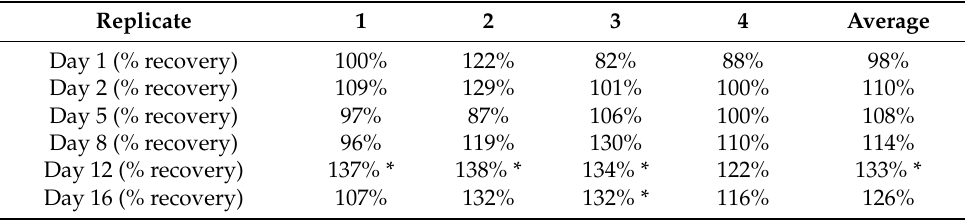
Table 9. Stability of 500ppt v EtO, done in 50% humid air. Results that fail the ± 30% recovery criteria noted with